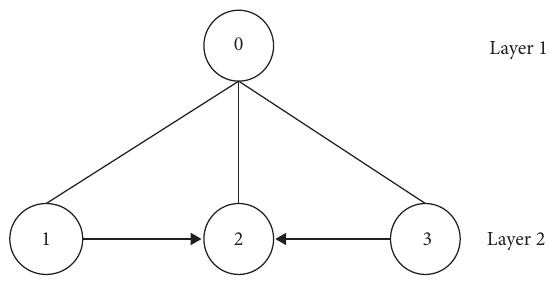
Figure 7: The directed graph of the planetary gear train. Table 1: System parameters.